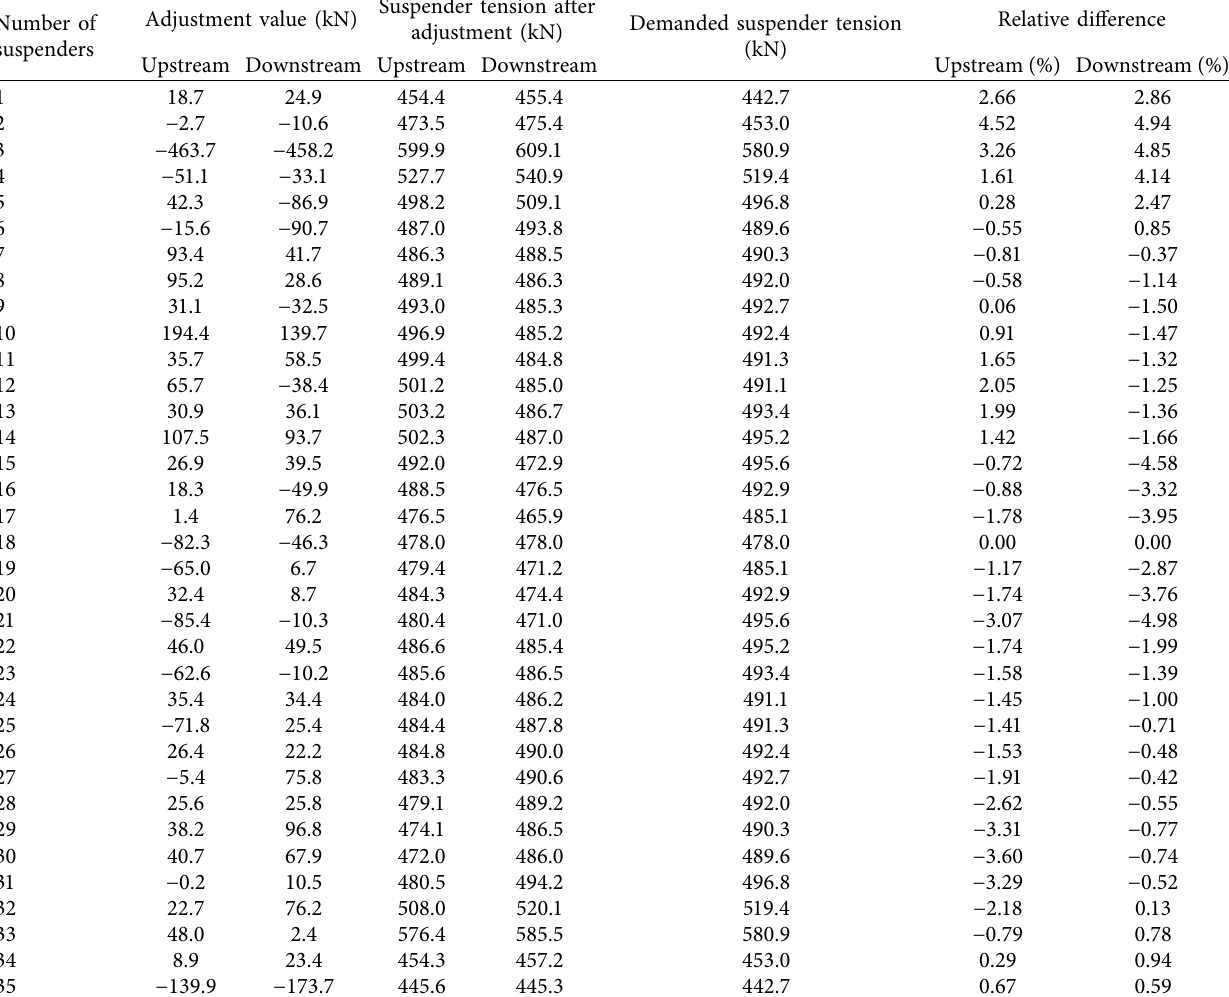
Table 3: Adjustment value and final suspender tension at completion state.